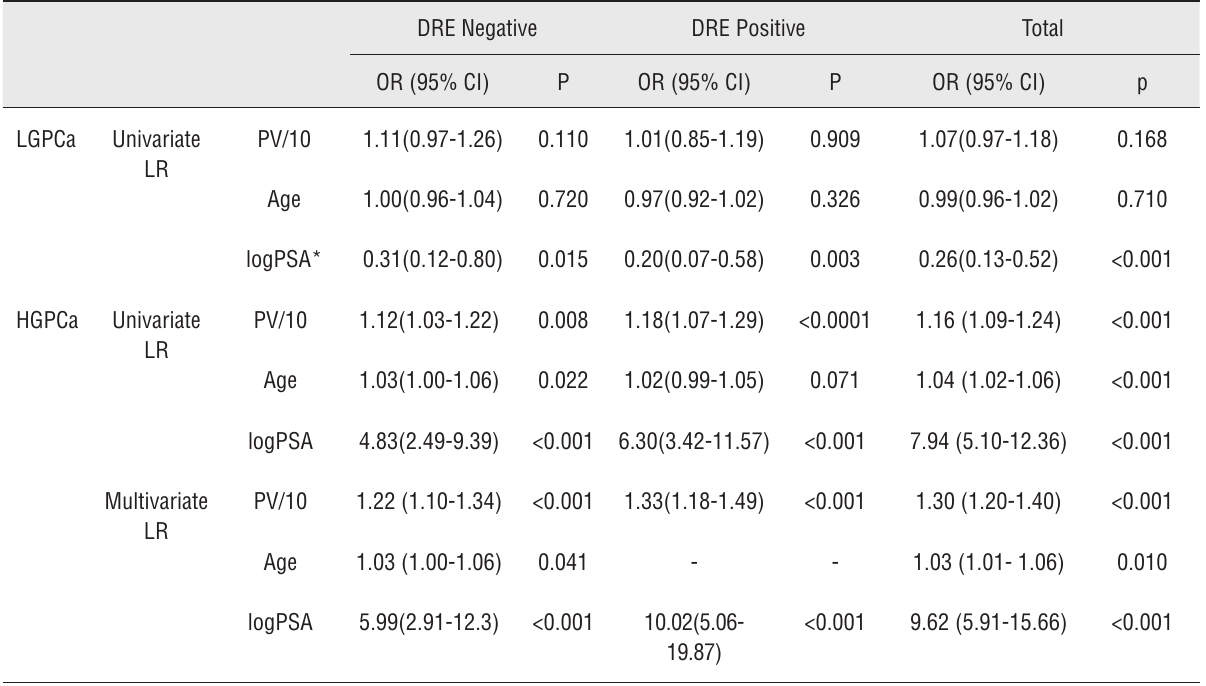
Table 2 - Logistic regression analyses of LGPCa and HGPCa in DRE negative and positive patients.